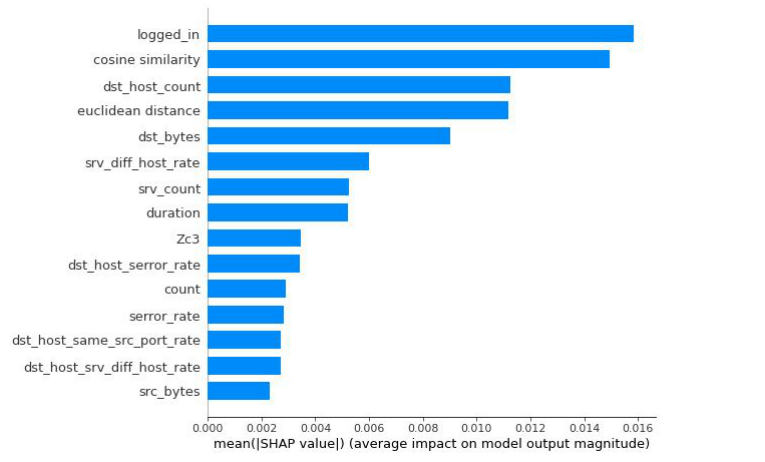
Figure 3. Bar graph of SHAP values calculated for the KDDCUP99 dataset using the EIF model of the MemAE-EIF